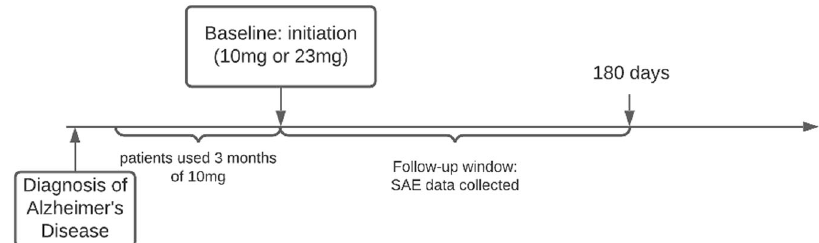
Fig. 2 Timeline showing how baseline and follow-up window are de fi ned. Patients who used 3 months of 10 mg donepezil were included in the study, their fi rst use of 10 mg or 23 mg donepezil after the 3-month were used as baseline. The follow-up window is from baseline to 180 days after drug initiation. Follow-up window for serious adverse events (SAEs) related to treating Alzheimer ’ s disease with